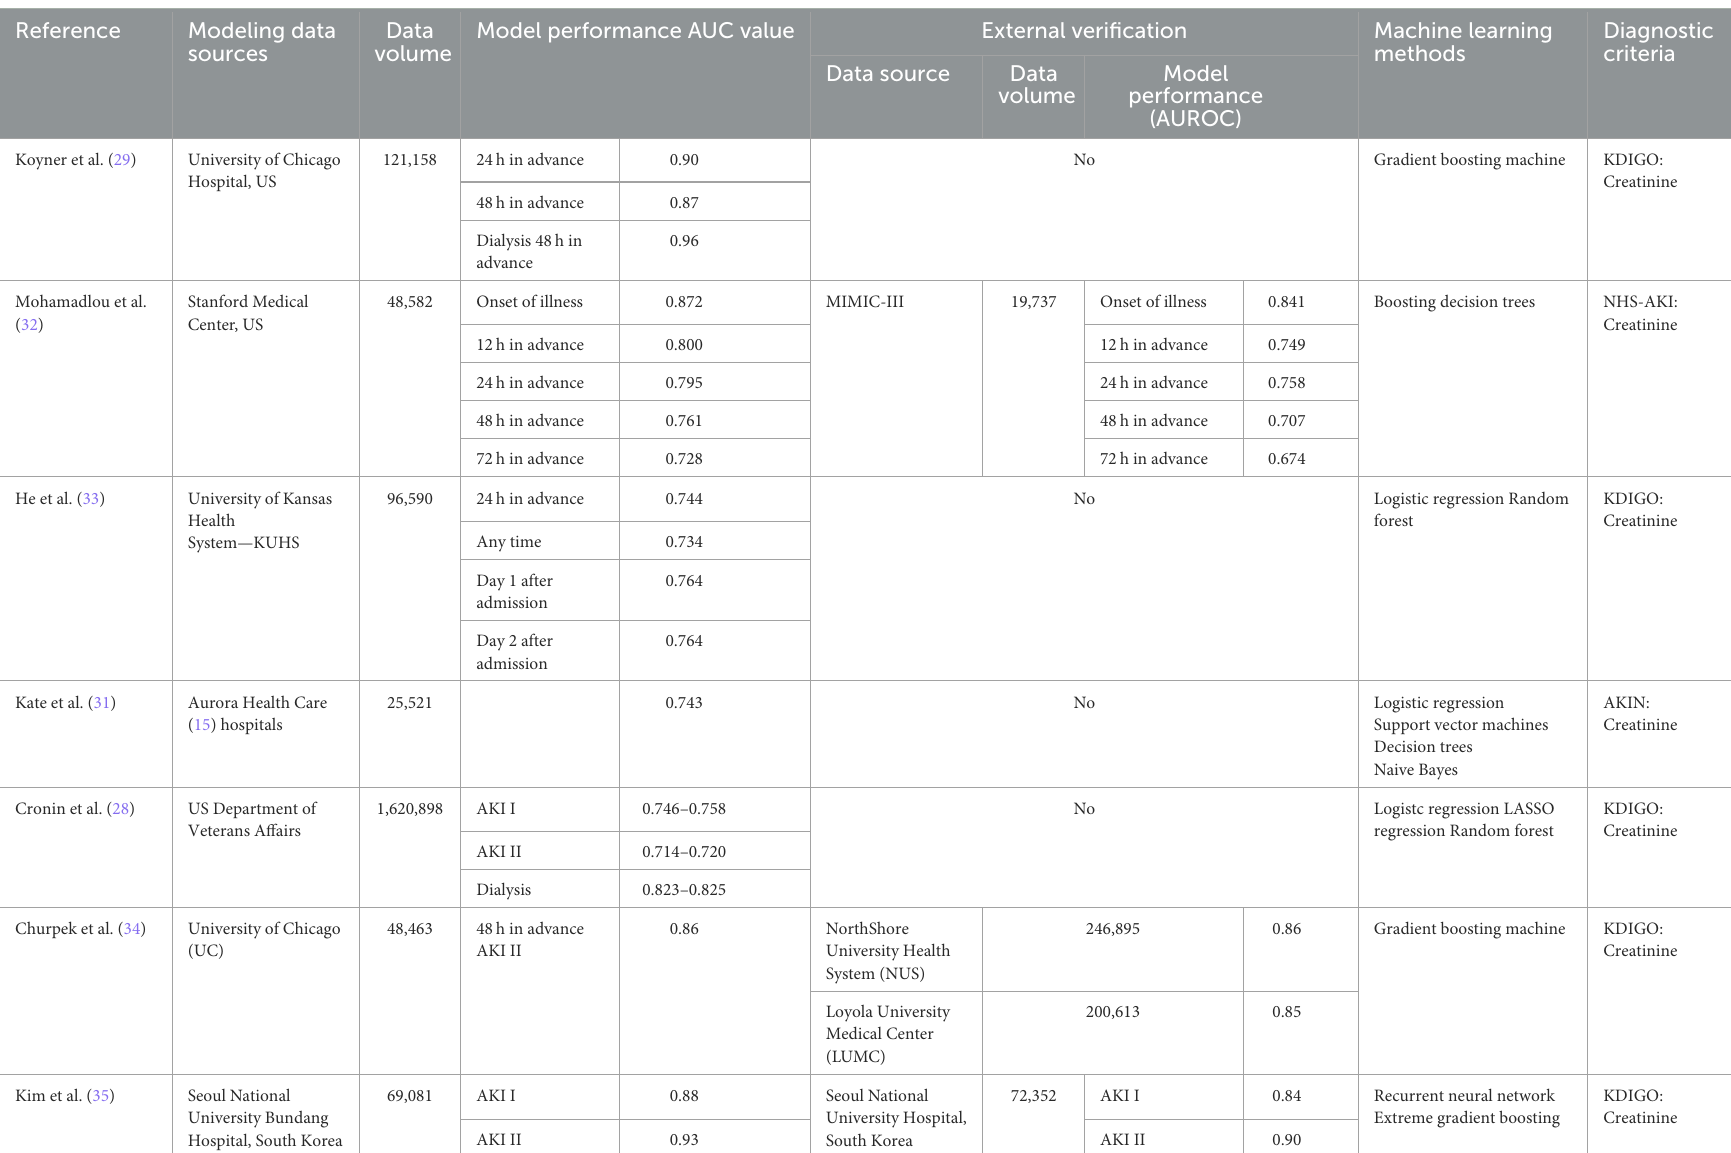
TABLE 3 AKI prediction model for all care